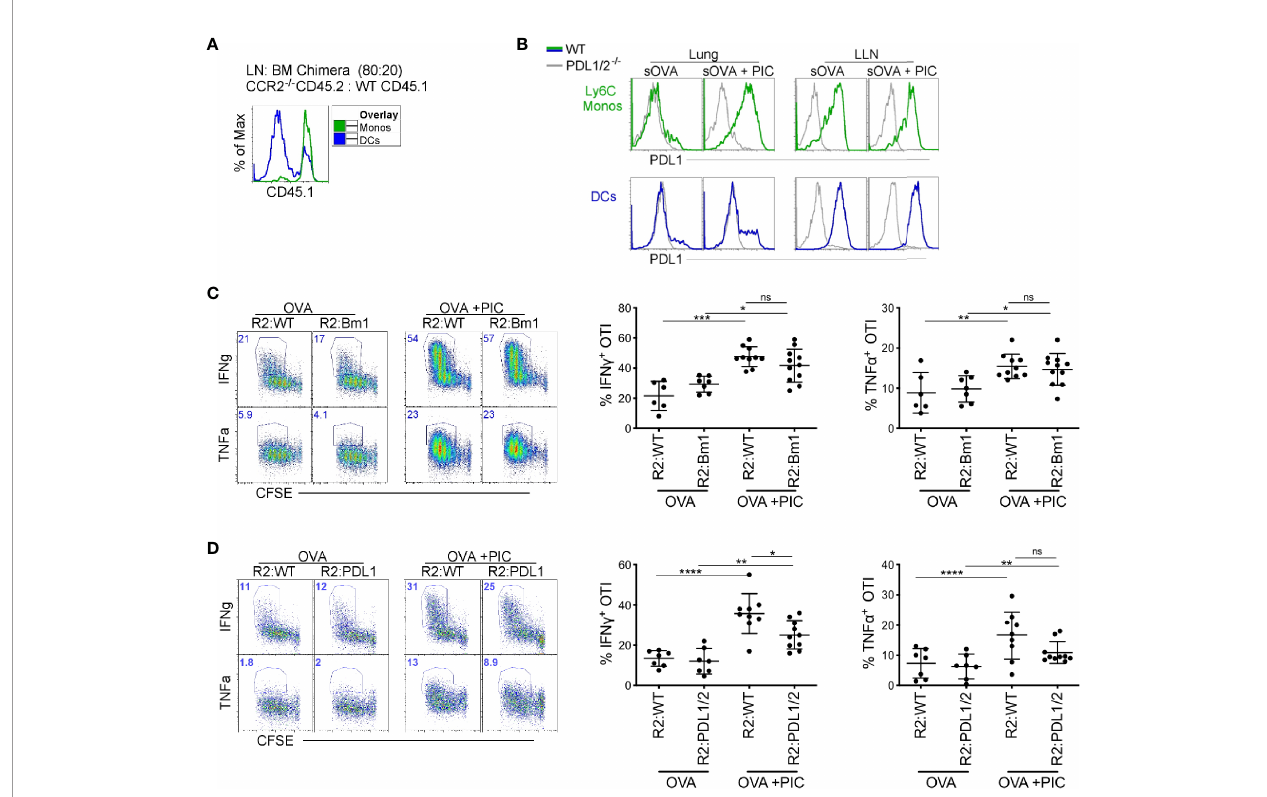
R2:Bm1 chimeric mice. Data are 3-4 independent experiments n=3-5 mice per group. Each dot represents a mouse. (D) Lethally irradiated mice were reconstituted 80:20 with CCR2 -/- and PDL1/2 -/- BM cells: R2:PDL1/2 chimeric mice. Control mice were reconstituted 80:20 with CCR2 -/- and WT BM cells: R2:WT chimeric mice. Scatter plot analysis of cytokine frequency from R2:WT and R2:PDL1/2 chimeric mice. Data are 2 independent experiments, n=3-5 mice per group. Data are shown as mean ± SEM. Each dot represents a mouse. ****P <0.0001. ***P value < 0.001. **P value < 0.01. *P value < 0.05. Non-signi fi cant